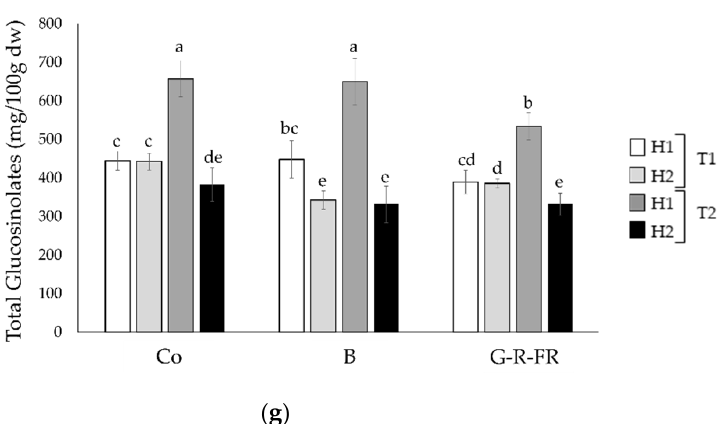
Figure 2. Individual glucosinolate, ( a ) glucoraphanin, ( b ) glucoiberin, ( c ) glucobrassicin, ( d ) 4-hydroxyglucobrassicin, ( e ) neoglucobrassicin, ( f ) 4-methoxyglucobrassicin, and ( g ) total glucosinolate content of broccoli samples across all the harvests and light treatments. The different letters represent significant differences between samples ( p < 0.05).